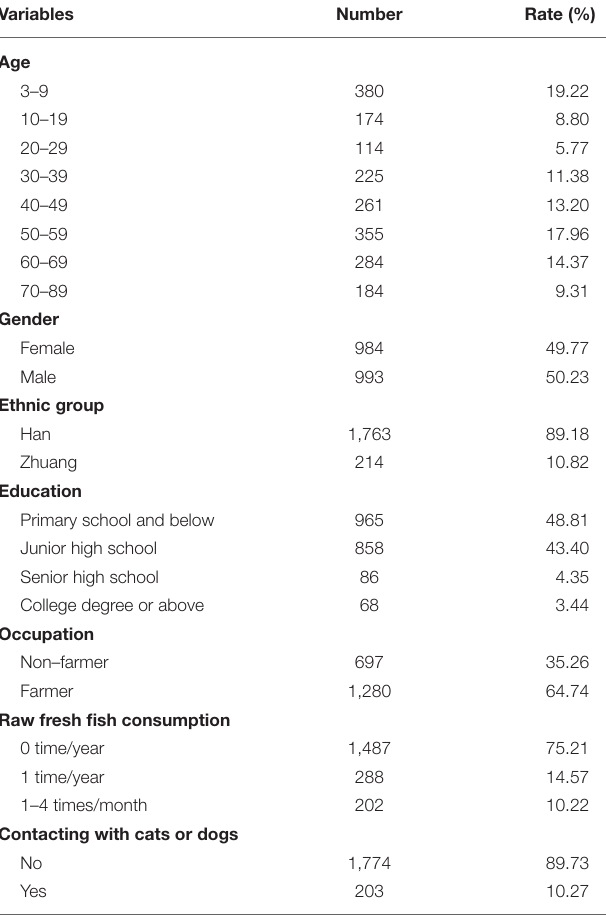
TABLE 1 | Socio-demographic characteristics of participants ( n = 1,977). Variables Number